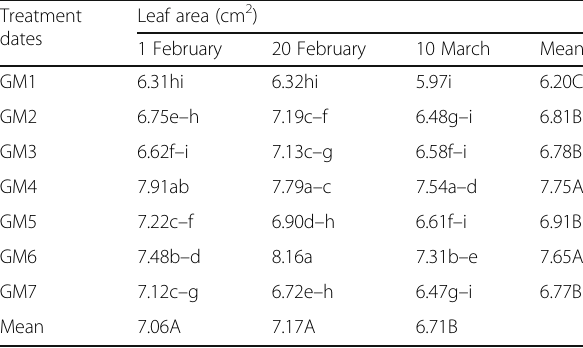
Table 4 Effect of planting dates and different growing media and the interactions between them on leaf area of pistachio seedlings